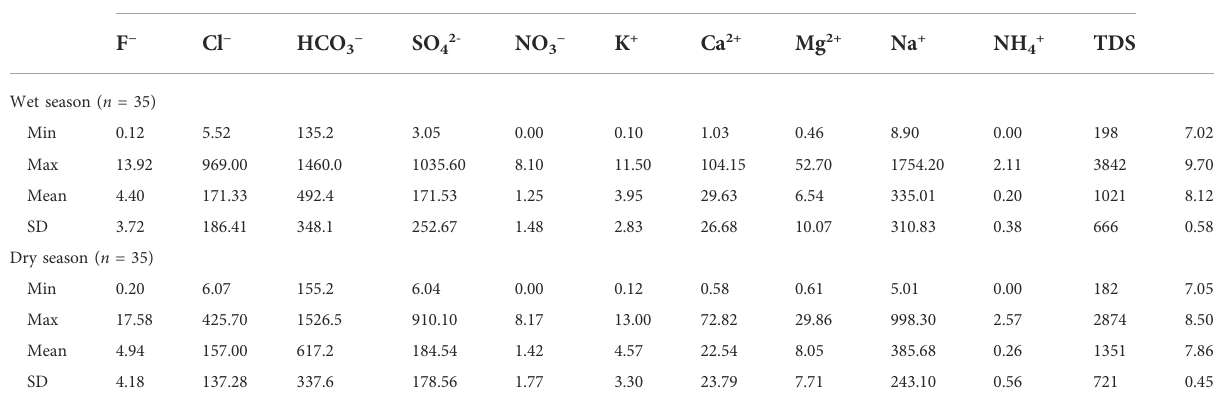
TABLE 2 Geochemistry data in deep groundwater for wet and dry